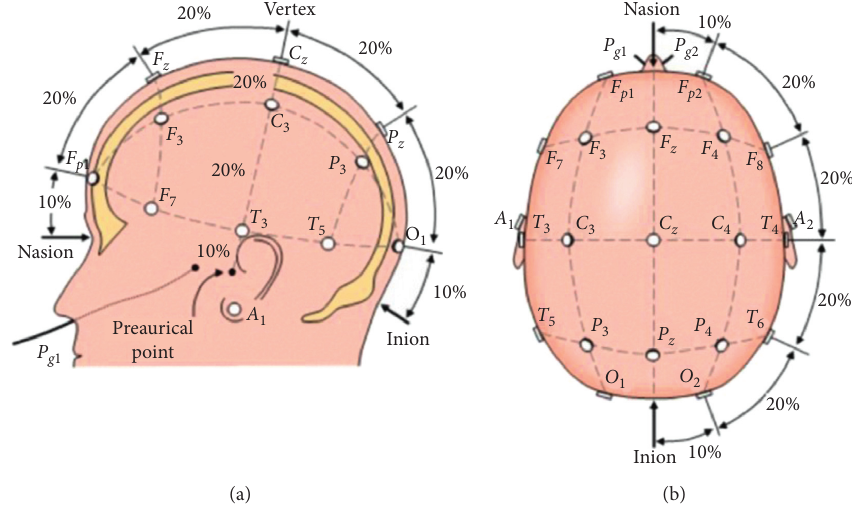
Figure 4: The international Ten-Twenty system seen from (a) left and (b) above the head